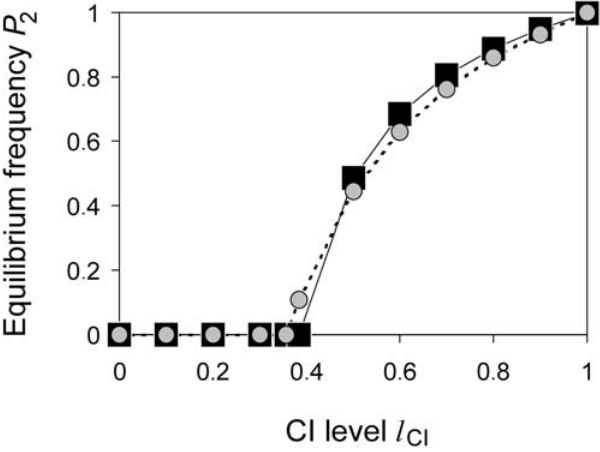
Figure 4. Equilibrium frequencies of P 2 after introduction on the island with the low frequency of 0.1%. Black squares indicate simulation results, gray circles values determined by formula (16). The figure illustrates the finding that P 2 spreads on the island if the CI level is above a threshold but goes to extinction if the CI level is below. Parameters are a 2 =10, f =0.1, s =0.1, m =0.003.